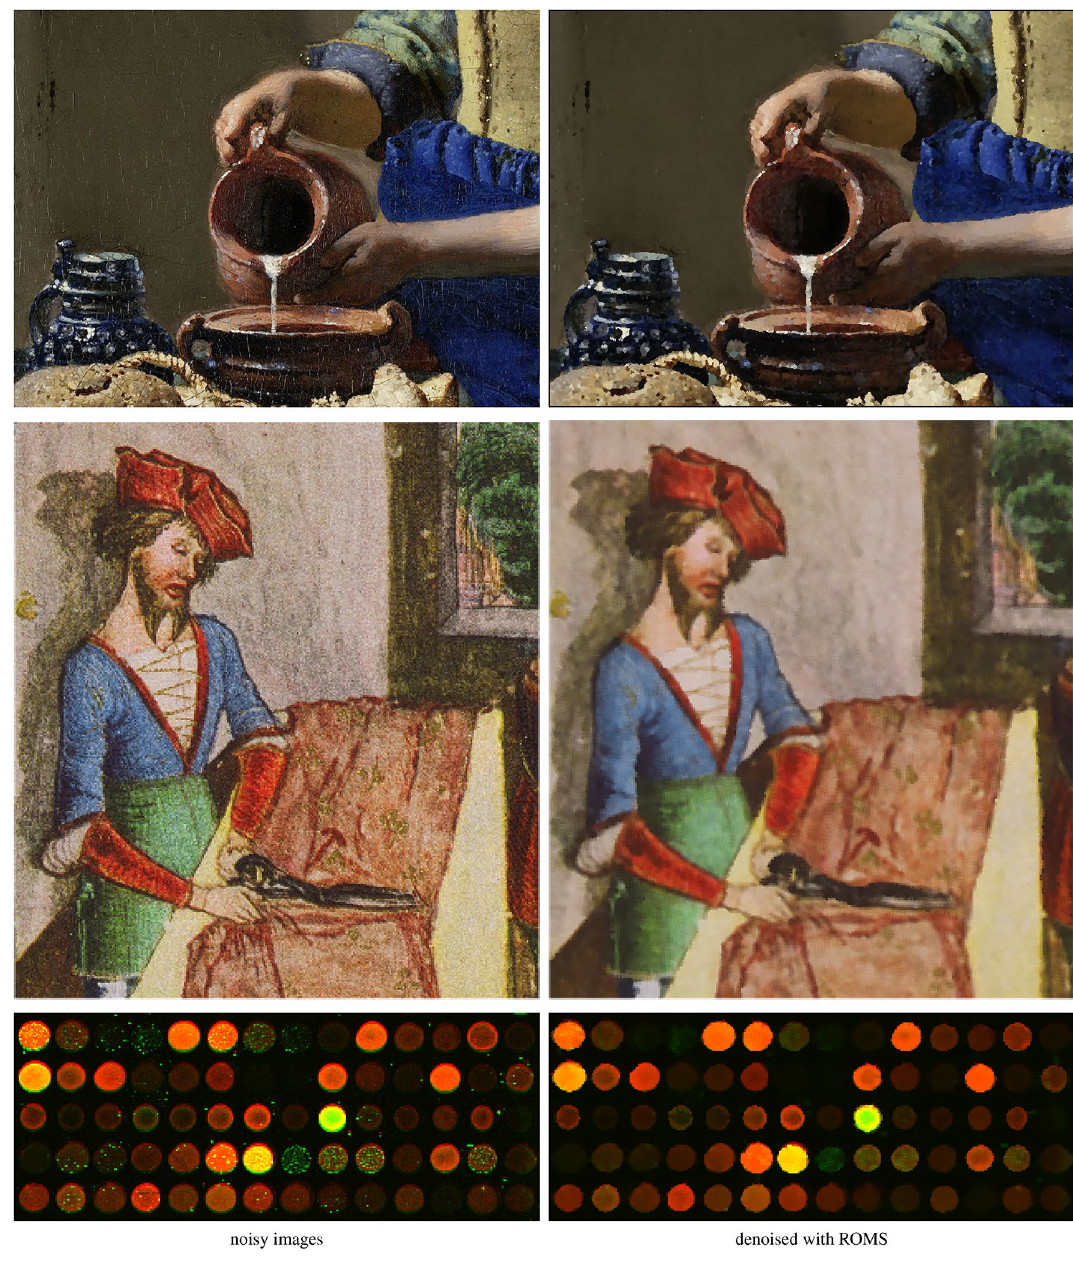
Figure 11. Filtering results of the proposed ROMS using real noisy images. From top to bottom: cropped and zoomed part of the painting “The Milkmaid” by Johannes Vermeer, a miniature from the Balthasar Behem Codex and a cDNA microarray 116 . The images were processed using the parameters: α = 3 , σ = 30 and r = 1